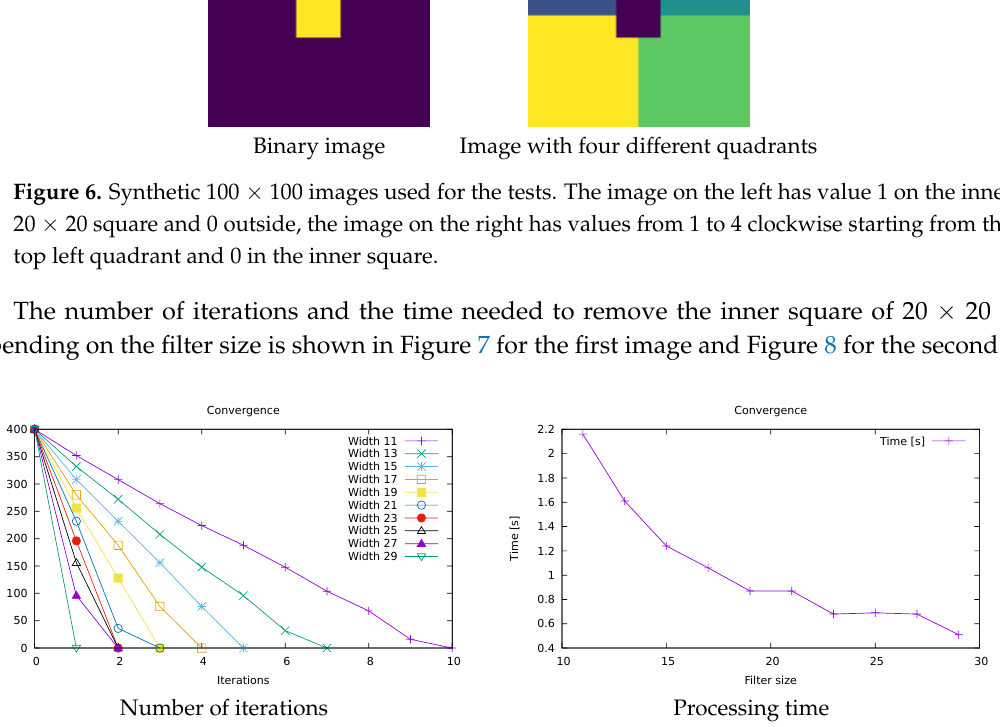
Figure 7. Number of iterations and processing time needed to remove a 20 × 20 pixels square on a binary 100 × 100 image depending on the filter size.